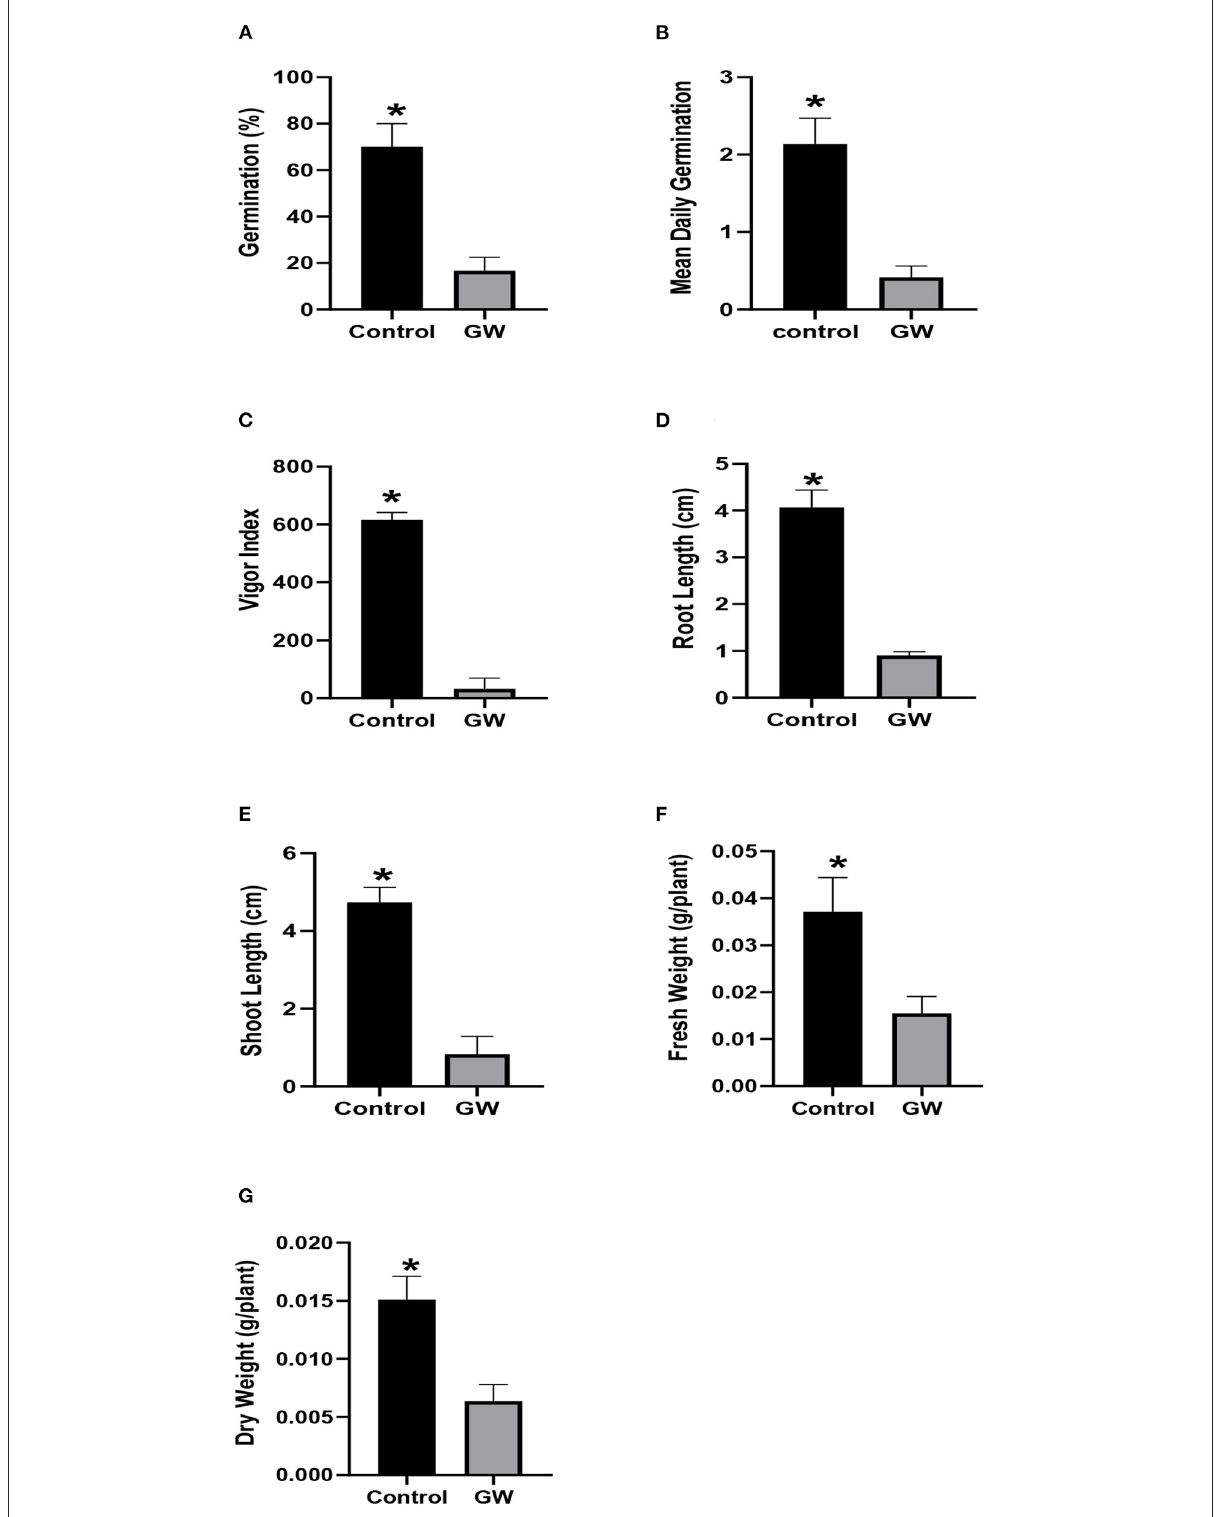
FIGURE2 Effect of FCF from endophytic fungus F. oxysporum GW on the germination (A) , mean daily germination (B) , Vigor index (C) , root length (D) , shoot length (E) , fresh weight (F) , and dry weight (G) of Avena fatua seedlings for 1 week after germination. Bars show the mean of three replicates with standard deviation. Bars labeled with * are significantly higher ( t -test; p <